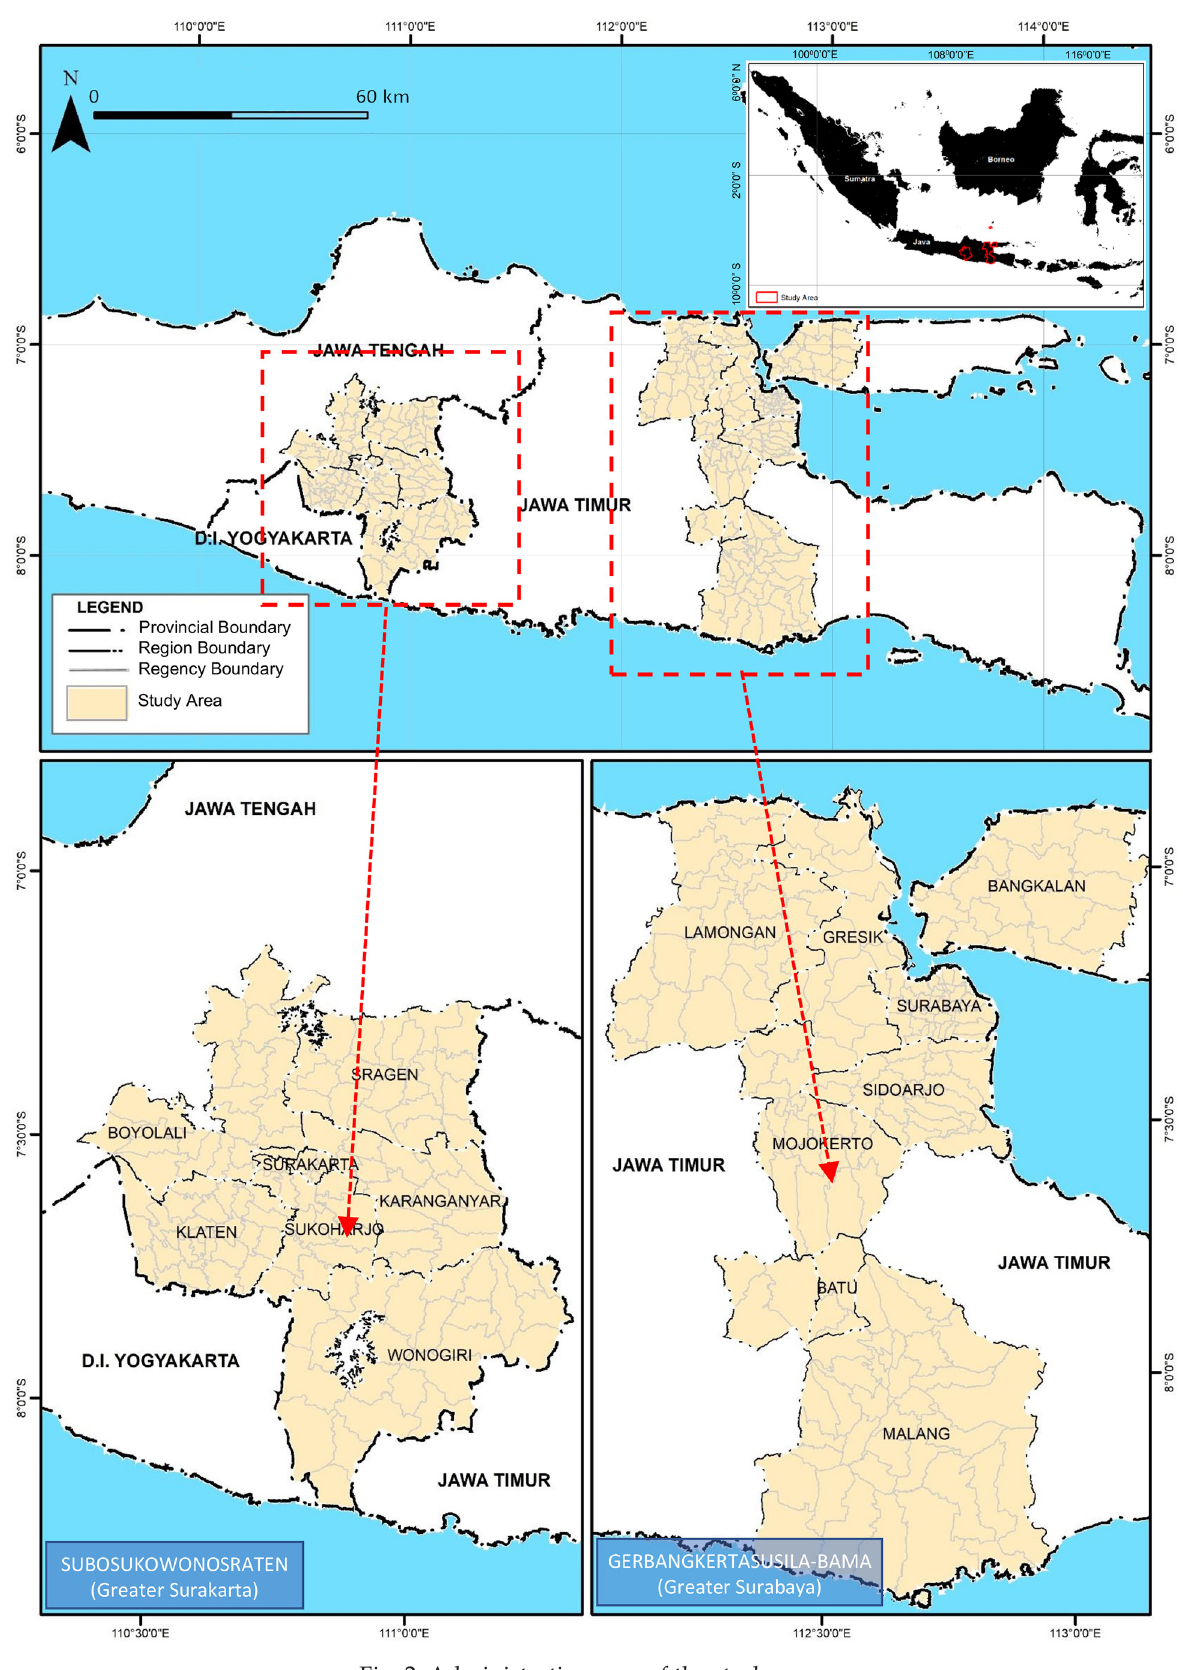
Fig. 2. Administrative map of the study